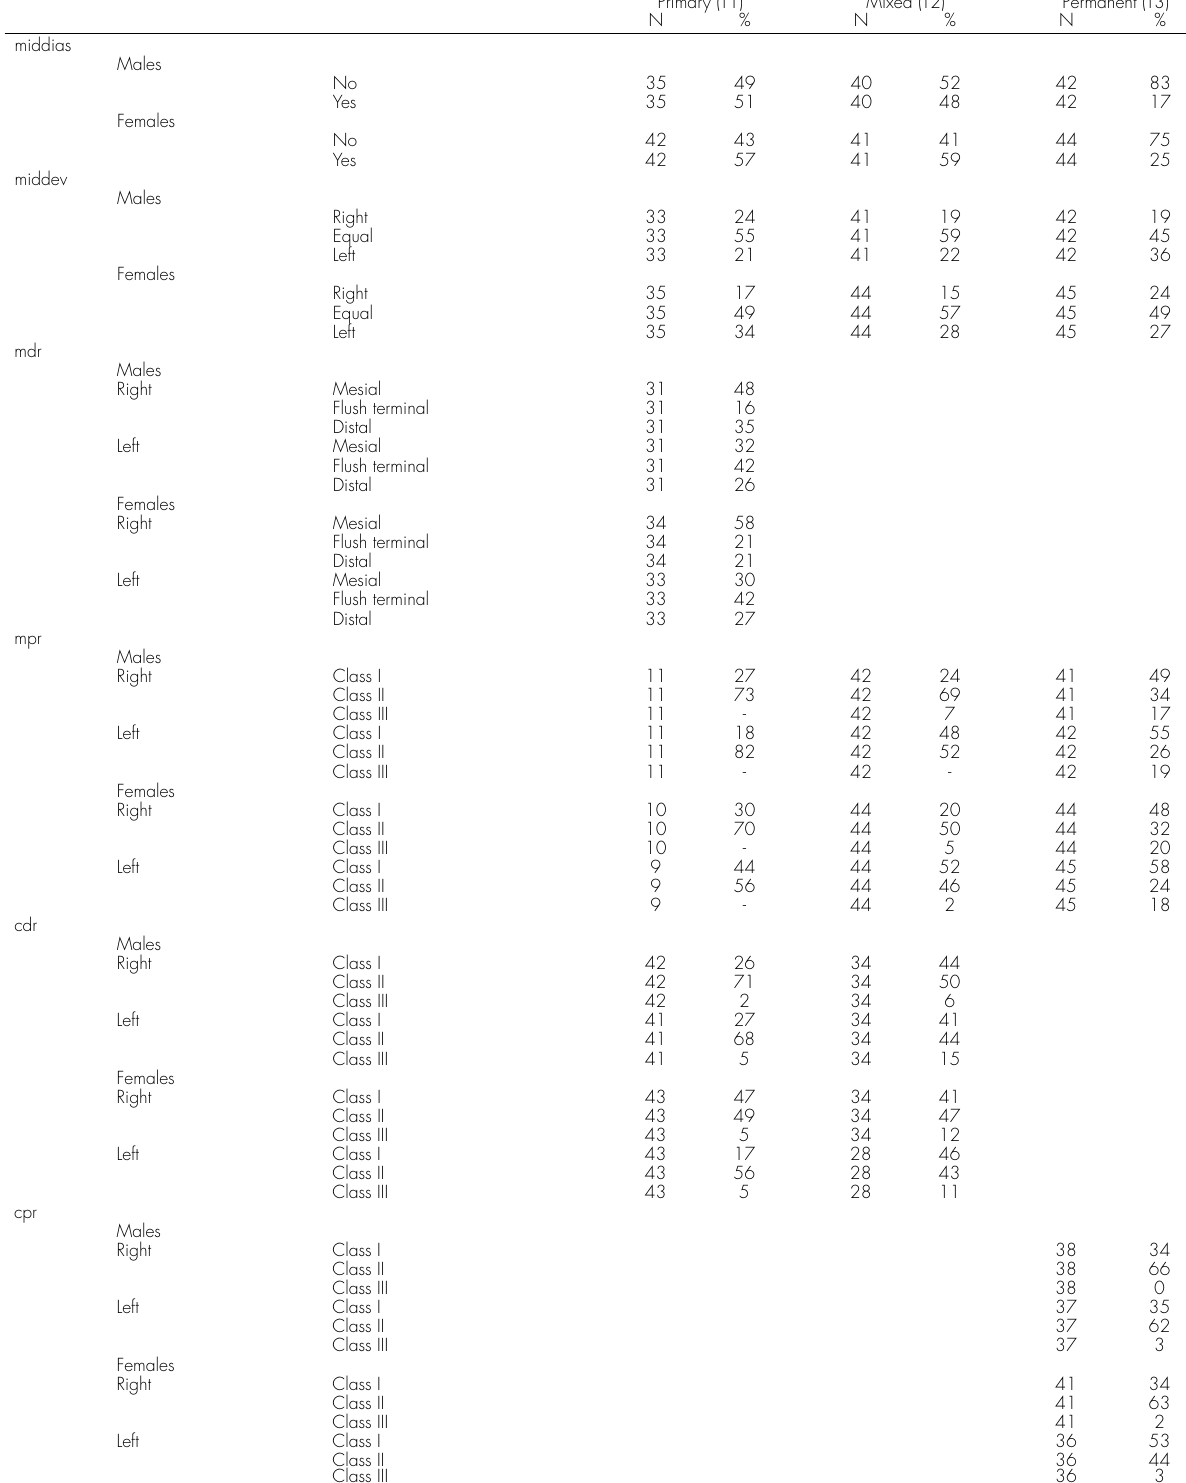
Table II. Frequencies of midline diastema, midline deviation, primary molar relationship, permanent molar relationship, primary canine relationship, permanent canine relationship of males and females from monozygotic (MZ) and dizygotic (DZSS) twins in the primary (T1), mixed (T2), and permanent (T3)